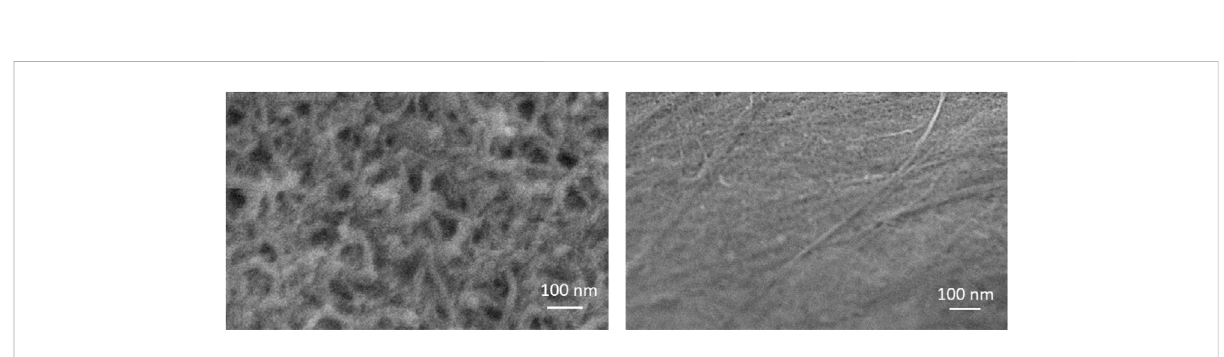
FIGURE 4 SEM images of MWCNT-MB (left) and PDA/MWCNT (right) modi fi ed glassy carbon